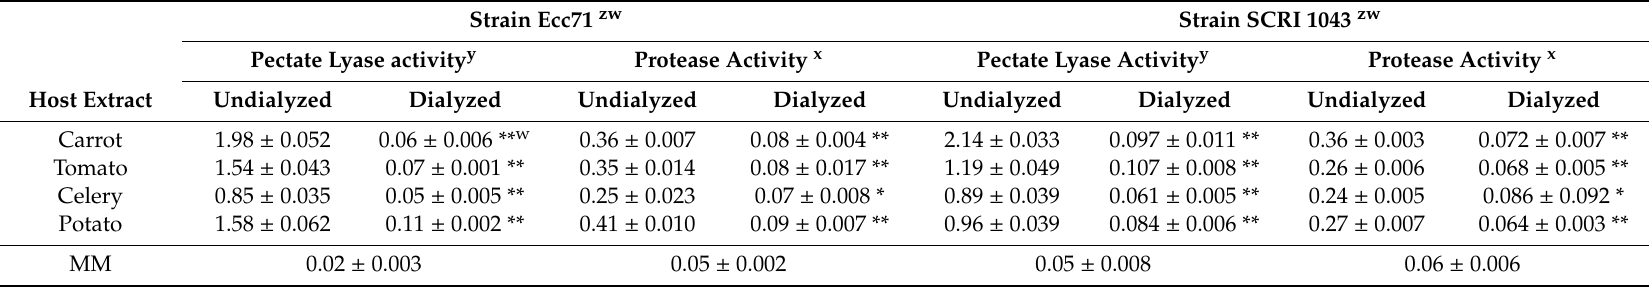
Table 3. Pectate lyase and protease activities produced by Pectobacterium strains in media supplemented with dialyzed or undialyzed cut and autoclaved extracts from di ff erent